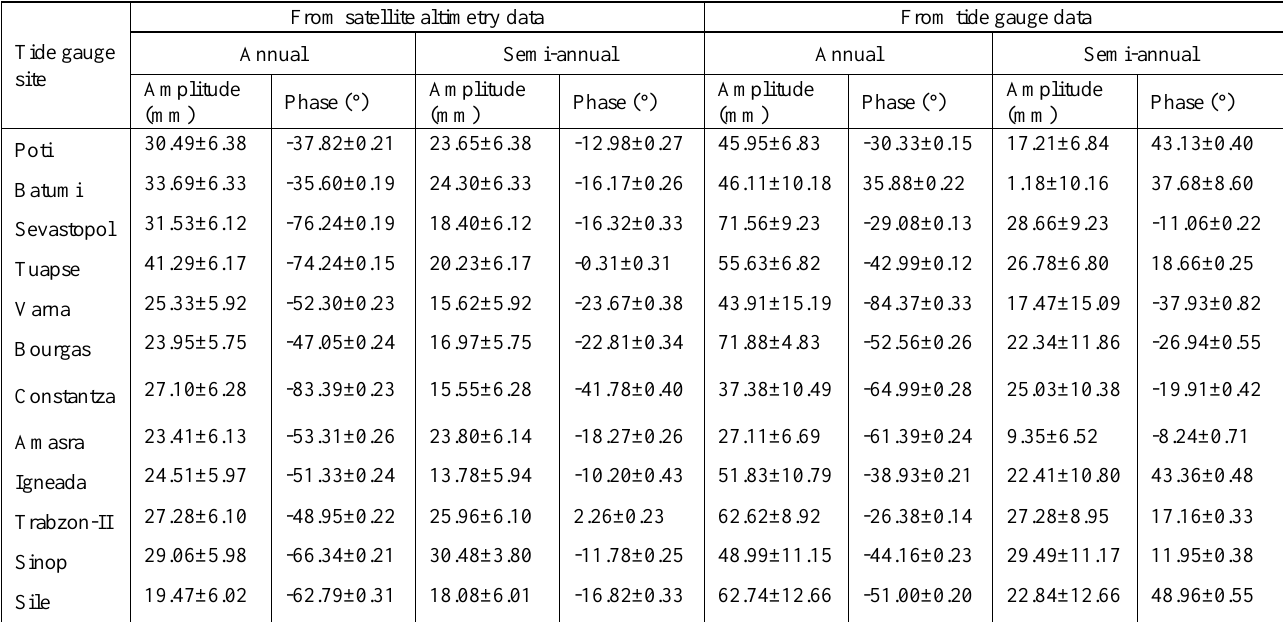
Table 3. Seasonal components of satellite altimetry and tide gauge time series